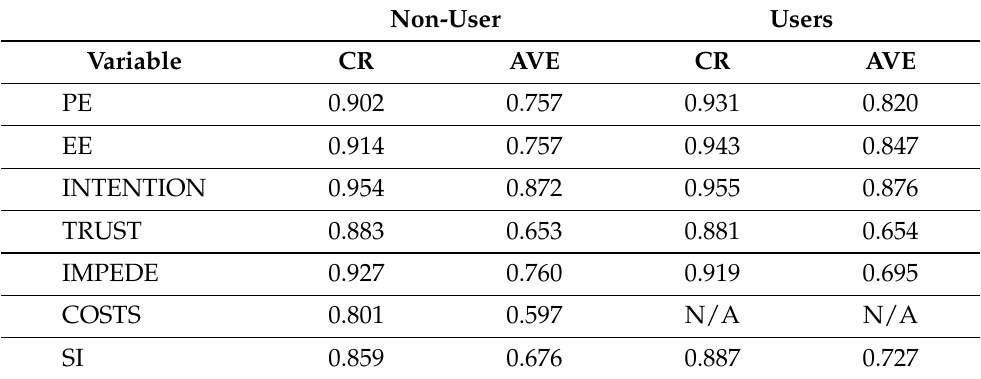
Table 2. Composite Reliability (CR) and Average Variance Extracted (AVE)